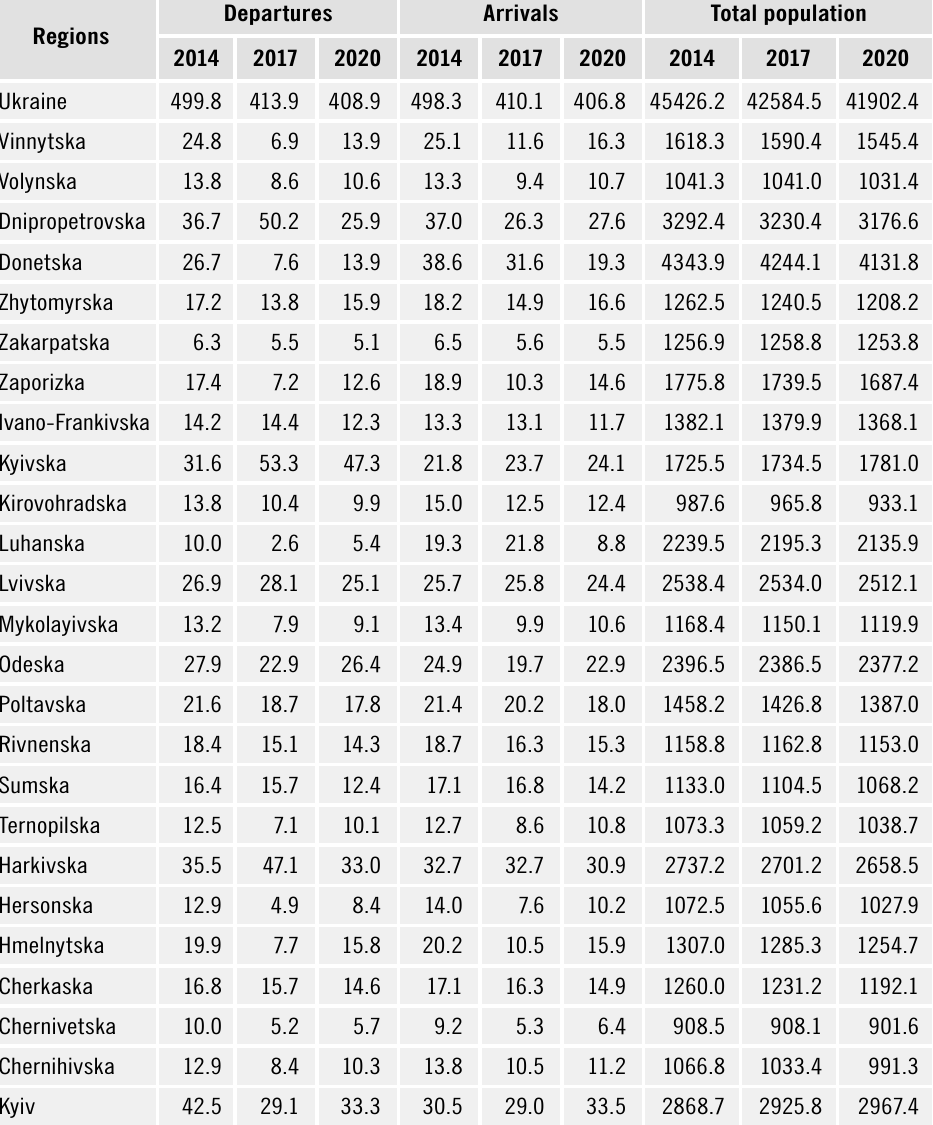
Table 1. Scale of departures and arrivals, total population of Ukraine (regional vector), in thousands of